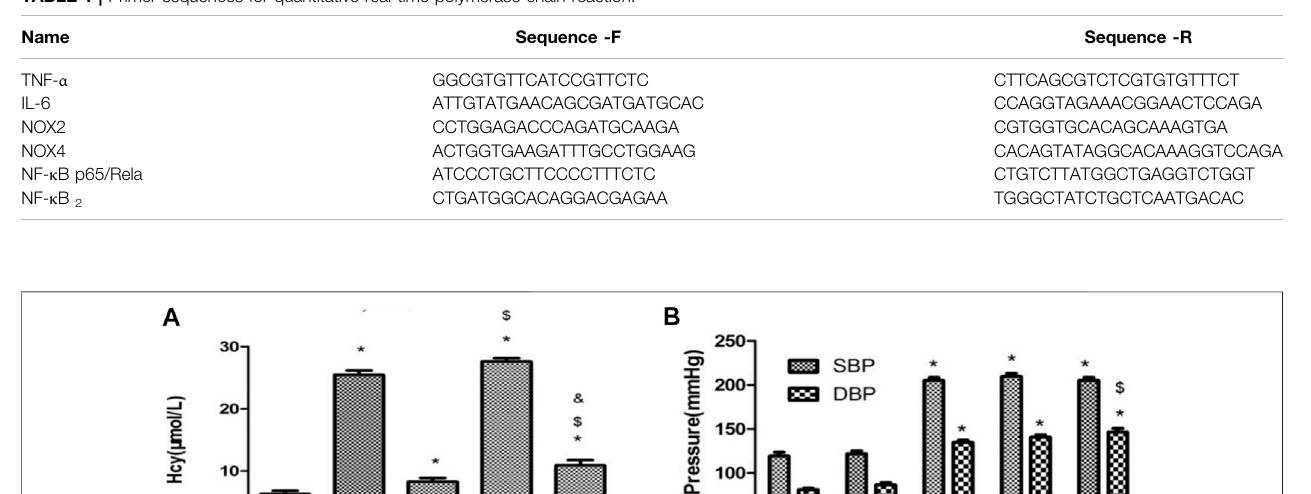
TABLE 1 | Primer sequences for quantitative real-time polymerase chain reaction.